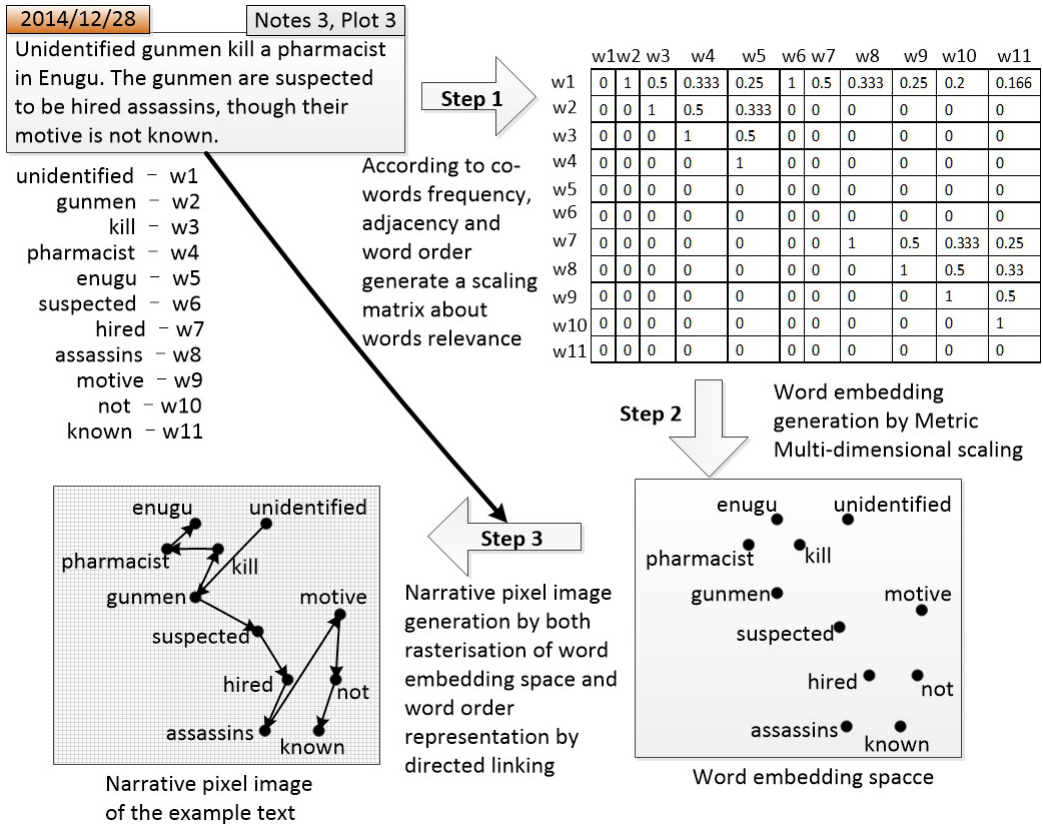
Figure 5. Modeling procedure of a narrative pixel